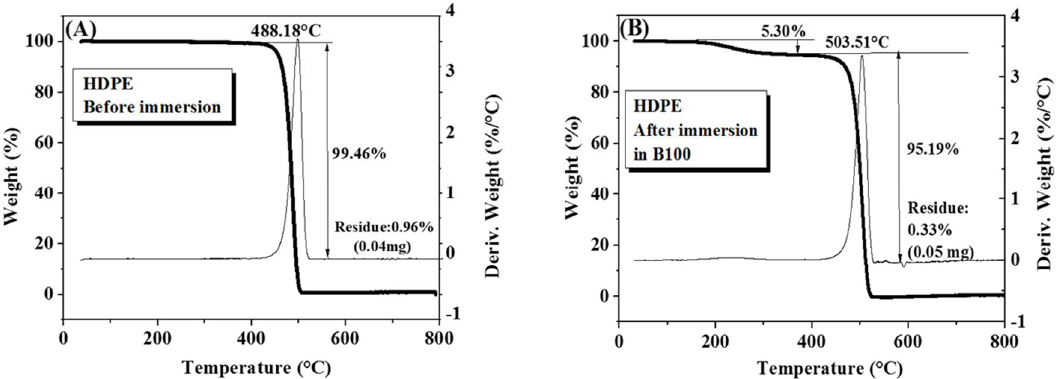
Figure 6. Thermogravimetric analysis (TGA) curves of high-density polyethylene (HDPE) samples. ( A ) Before immersion; ( B ) after immersion in B100.